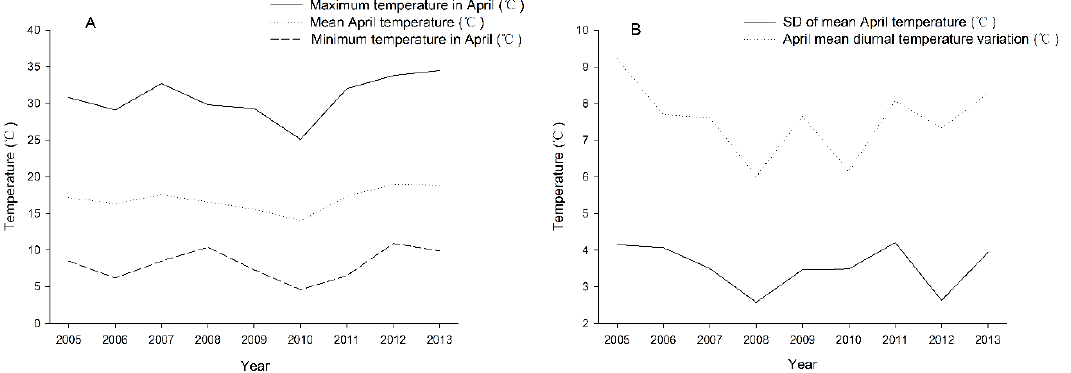
Figure 3. April climate data (2005–2013) collected from Anji County, Huzhou City, Zhejiang Province, China. ( A ): The mean April temperature ( ◦ C), the maximum temperature in April ( ◦ C) and the minimum temperature in April ( ◦ C). ( B ): the SD of the mean April temperature ( ◦ C) and the April mean diurnal temperature variation ( ◦ C).